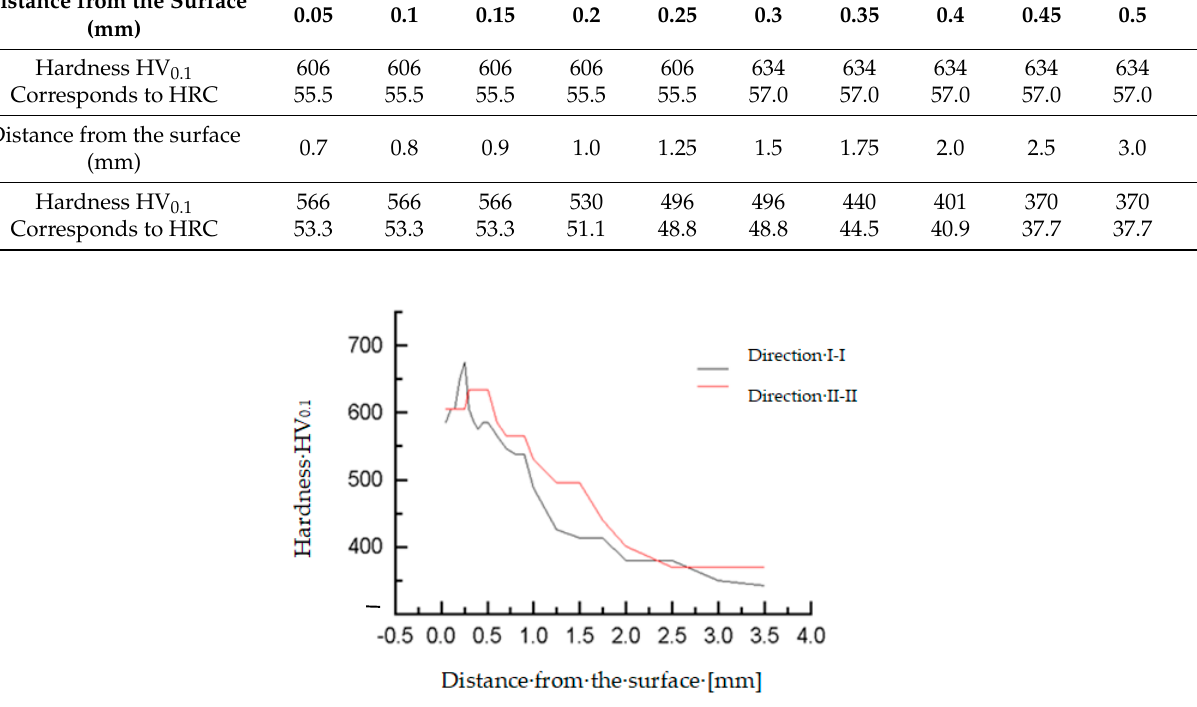
Table 6. Microhardness of tooth hard-faced with EVB2CrMo—direction II-II.